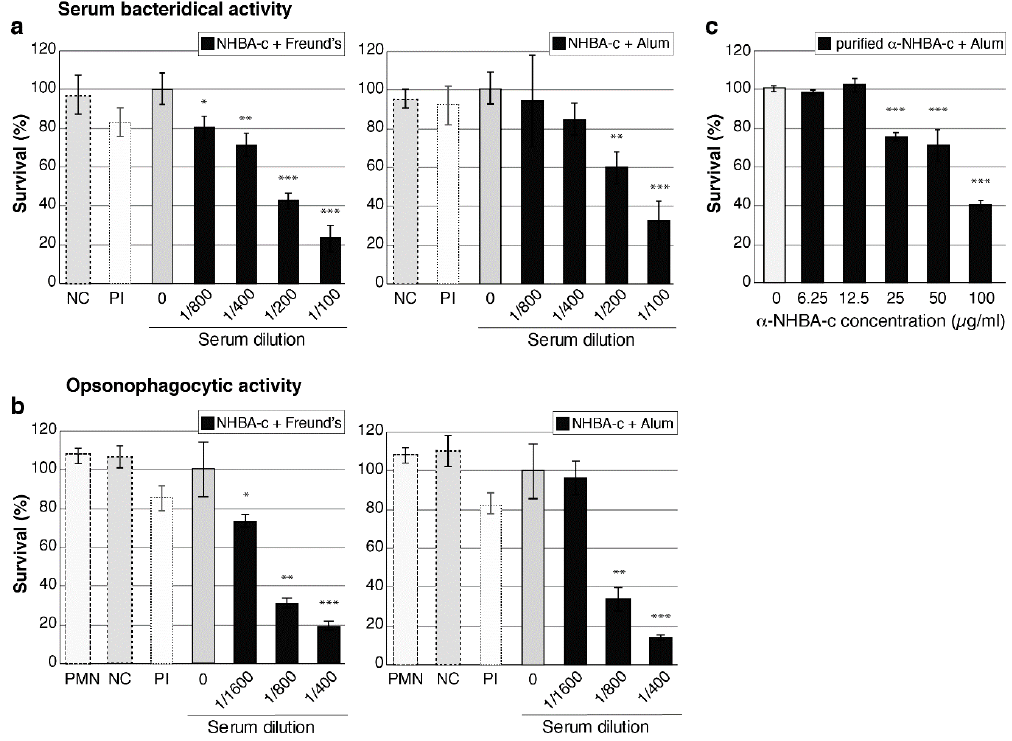
Figure 4. Serum bactericidal activity and opsonophagocytic activity of anti-NHBA antibodies. ( a , c ) Serum bactericidal activity (SBA) of anti-NHBA serum. The survival of N. gonorrhoeae strain